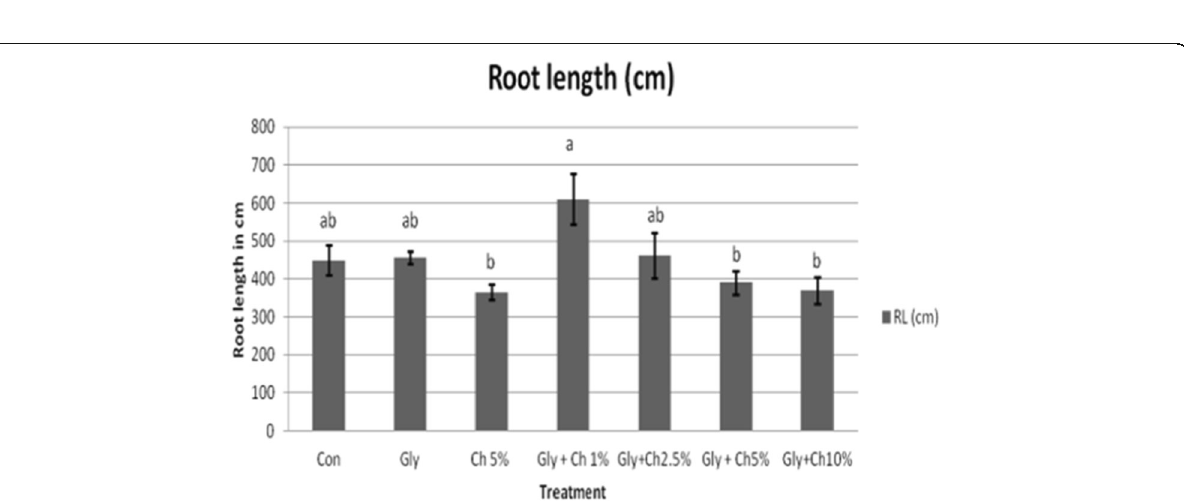
Fig. 7 Total root length of winter wheat seedlings (cv. Isengrain) of different treatments 14 days after seeding. Data show average treatment values of four independent replicates. Treatment letters were as follows: Cont = pure soil without glyphosate, Gly = glyphosate 6 L dose without biochar amendment, ch5% = biochar amendment of 5%, gly6L + ch1% = glyphosate with biochar amendment of 1%, Gly6L + ch2.5% = glyphosate with biochar amendment of 2.5%, Gly6L + ch5% = glyphosate with biochar amendment of 5%, and gly6L + ch10% = glyphosate with biochar amendment of 10%. Error bars indicating standard error. Different letters above the bars indicating significant differences ( α = 0.05)